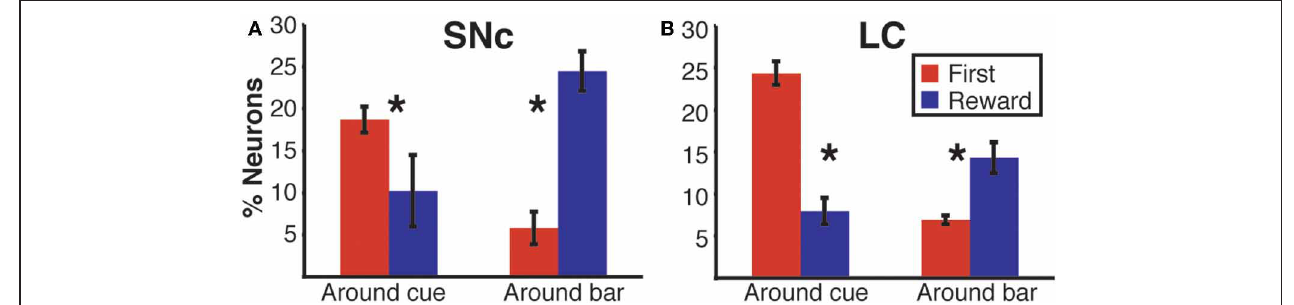
FIGURE 8 | Response modulation across epochs of a trial. Average percentage of neurons displaying a modulation of their firing between first and non-first (First modulation) or between rewarded and unrewarded trials (Reward modulation) in the SNc (A) and the LC (B) . Based on the results in Figure 7 , where the first-non-first and reward-noreward groups showed the same patterns, we grouped the data from the first three epochs and the last three epochs. Each bar is the mean and SEM of three measures taken at the